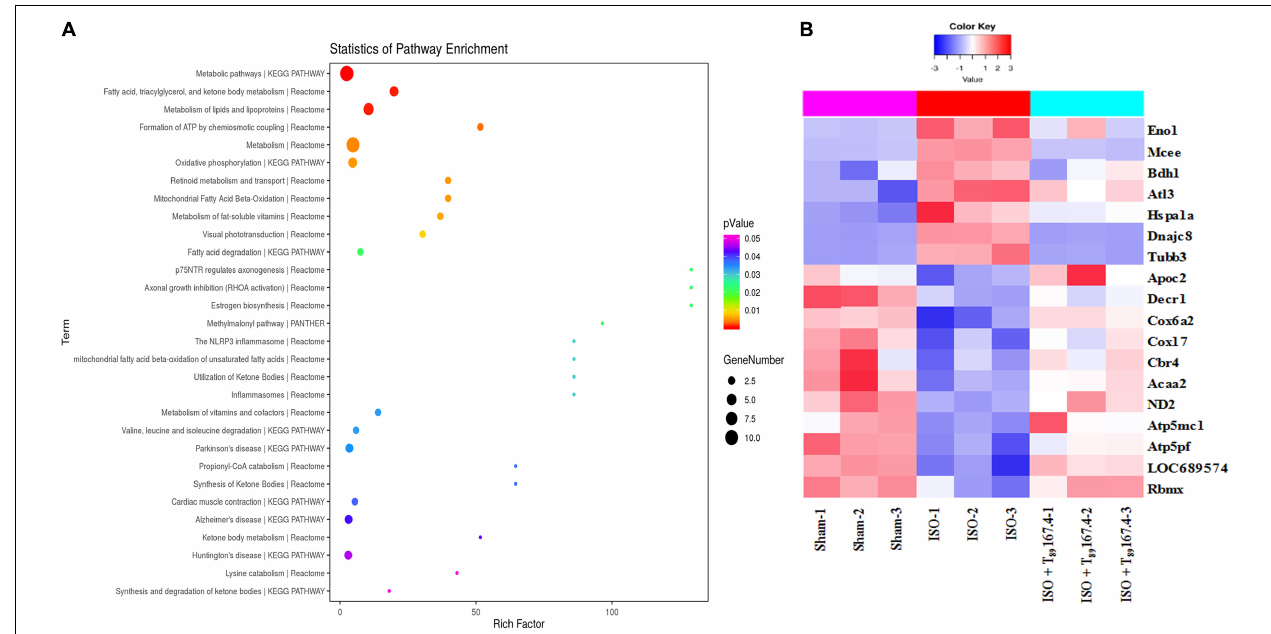
FIGURE 4 | TMT-proteomics analysis of ISO + T 89 group compared with the ISO group. (A) Statistics of pathway enrichment for the DEPs identified between ISO + T 89 group and ISO group. (B) The heat map of DEPs altered in Sham, ISO and ISO + T 89